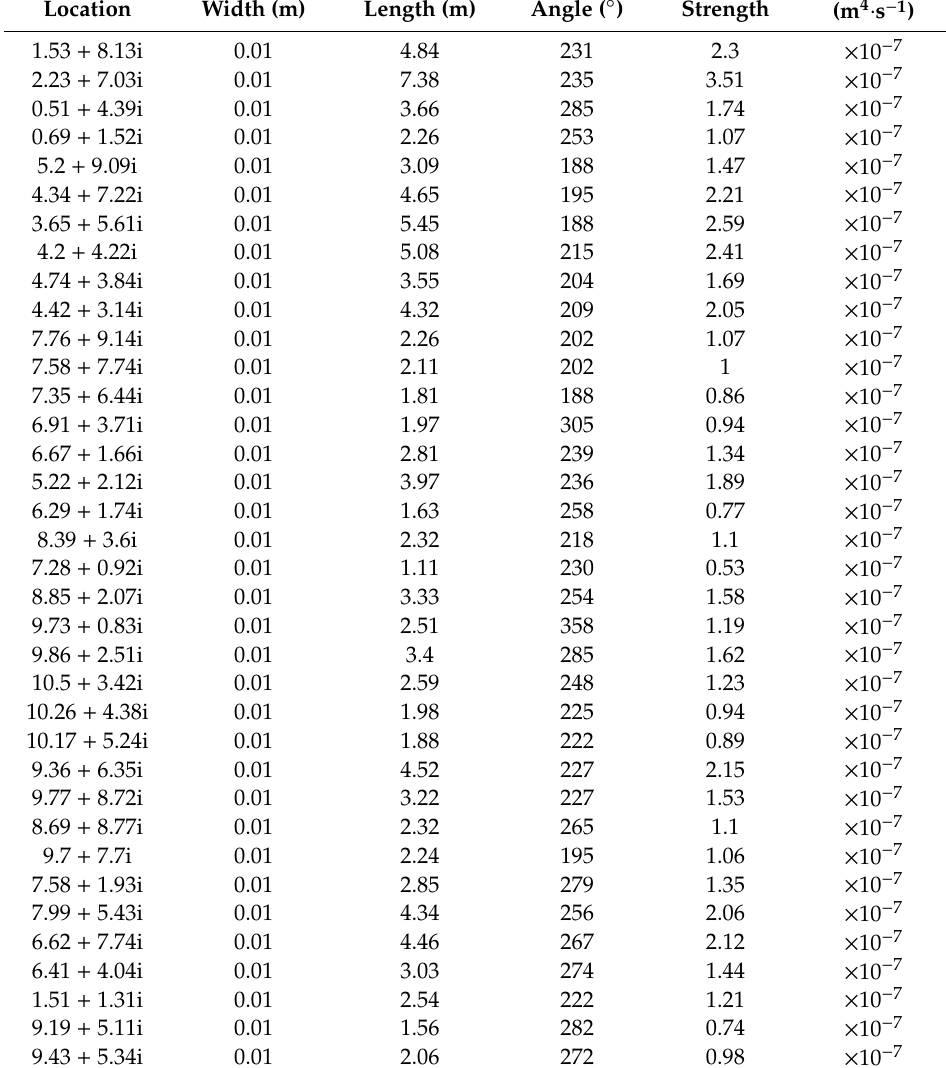
Table A7. Attributes of field case (Case